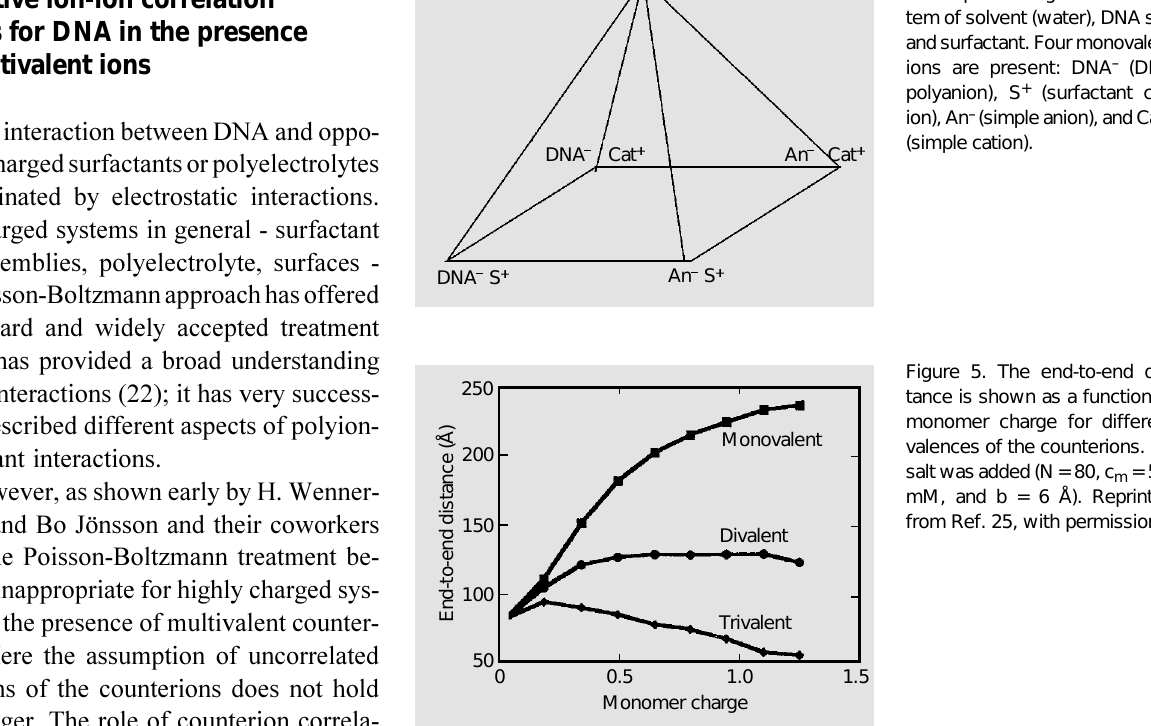
Figure 4. Pyramid representation of the phase diagram for a sys- tem of solvent (water), DNA salt and surfactant. Four monovalent